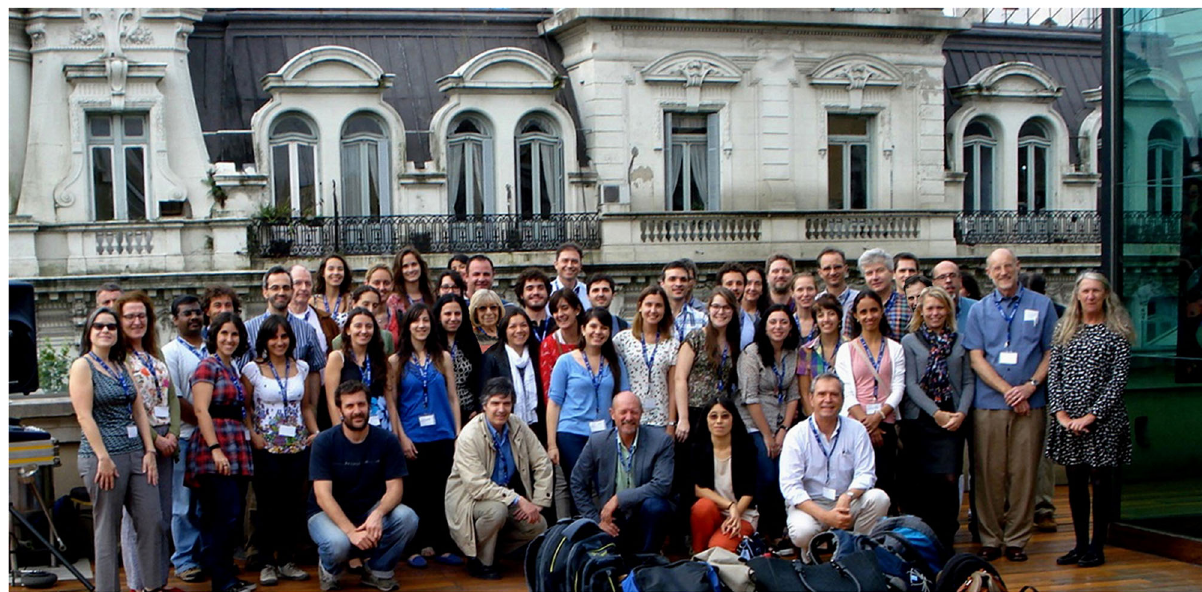
Fig. 1 SAMOC V Meeting Participants. Photo of the attendees at the fi fth SAMOC workshop in Buenos Aires, Argentina (SAMOC V, December 2014) reproduced from SAMOC meeting reports and proceedings found on https://www.aoml.noaa.gov/phod/SAMOC_international/.